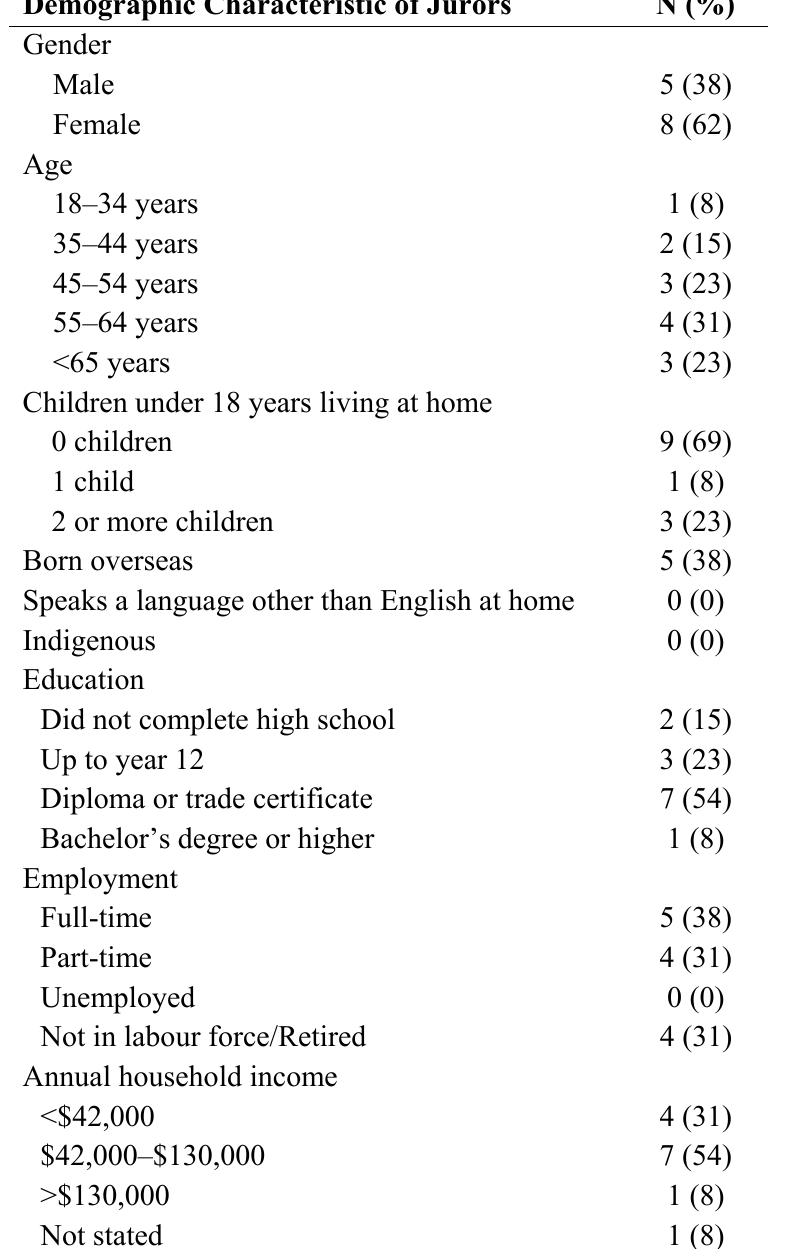
Table 2. Demographic characteristics of the